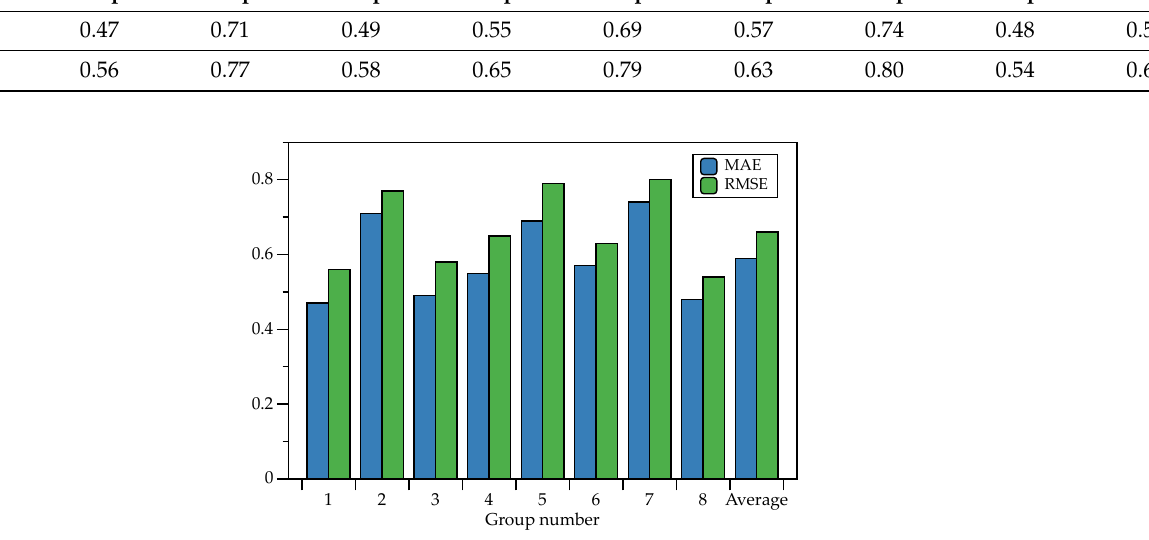
Figure 15. Comparison of MAE and RMSE of other experimental groups. Table 5. Summary of MAE and RMSE of other experimental groups.